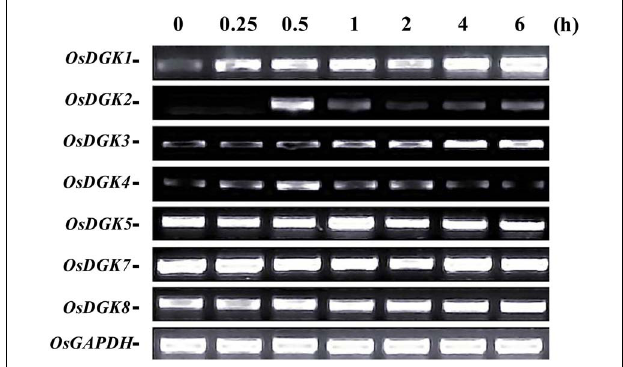
FIGURE 3 | RT-PCR analysis of OsDGK transcripts in rice cells treated with xylanase. Suspension cells were treated with 200 μ g/ml xylanase for the indicated times, and OsDGK transcripts were monitored by RT-PCR. Approximately 0.1 μ g of total RNA was used in each PCR. OsDGK6 was undetectable in cells with or without xylanase treatment.The OsGAPDH gene was used as an internal control.